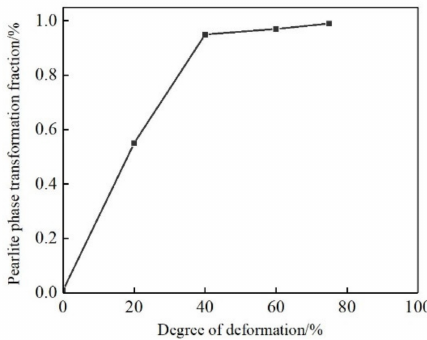
Figure 4. Pearlite fractions at different deformation